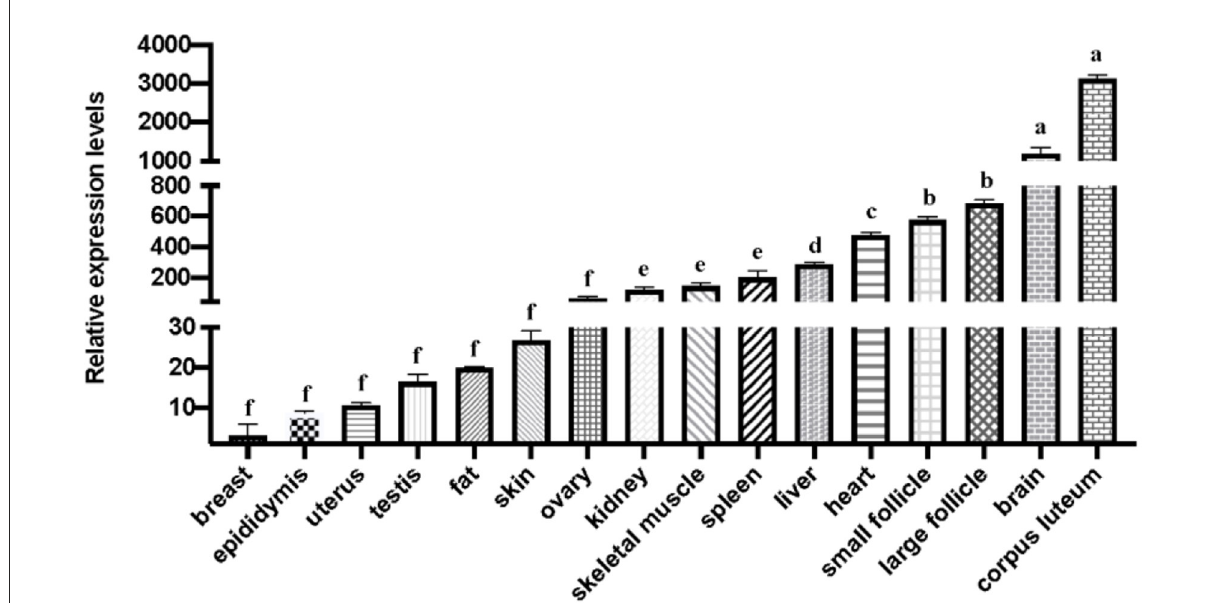
FIGURE1 The mRNA expression of the goat SNX29 gene. The values with different letters (a, b, d, e, f) indicates differ significantly at P < 0.05.